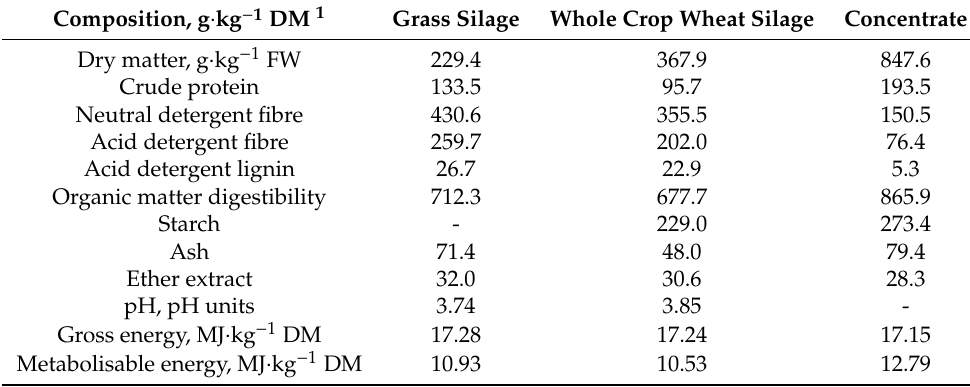
Table 1. Chemical composition of forages and concentrates offered to ewes during the final eight weeks of gestation.